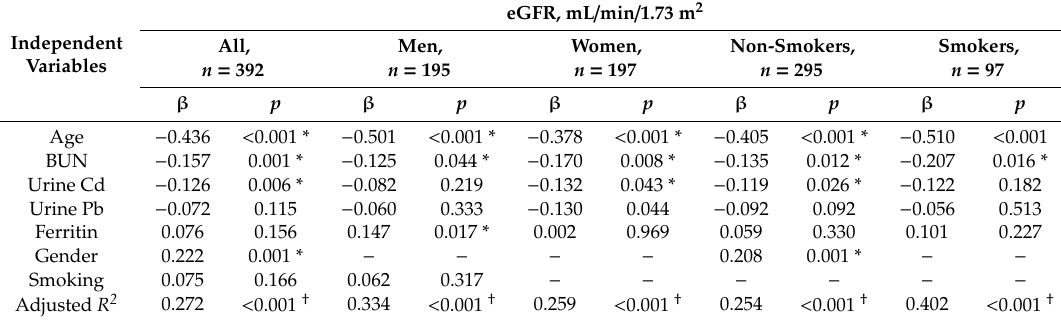
Table 2. Predictors of the estimated glomerular filtration rate